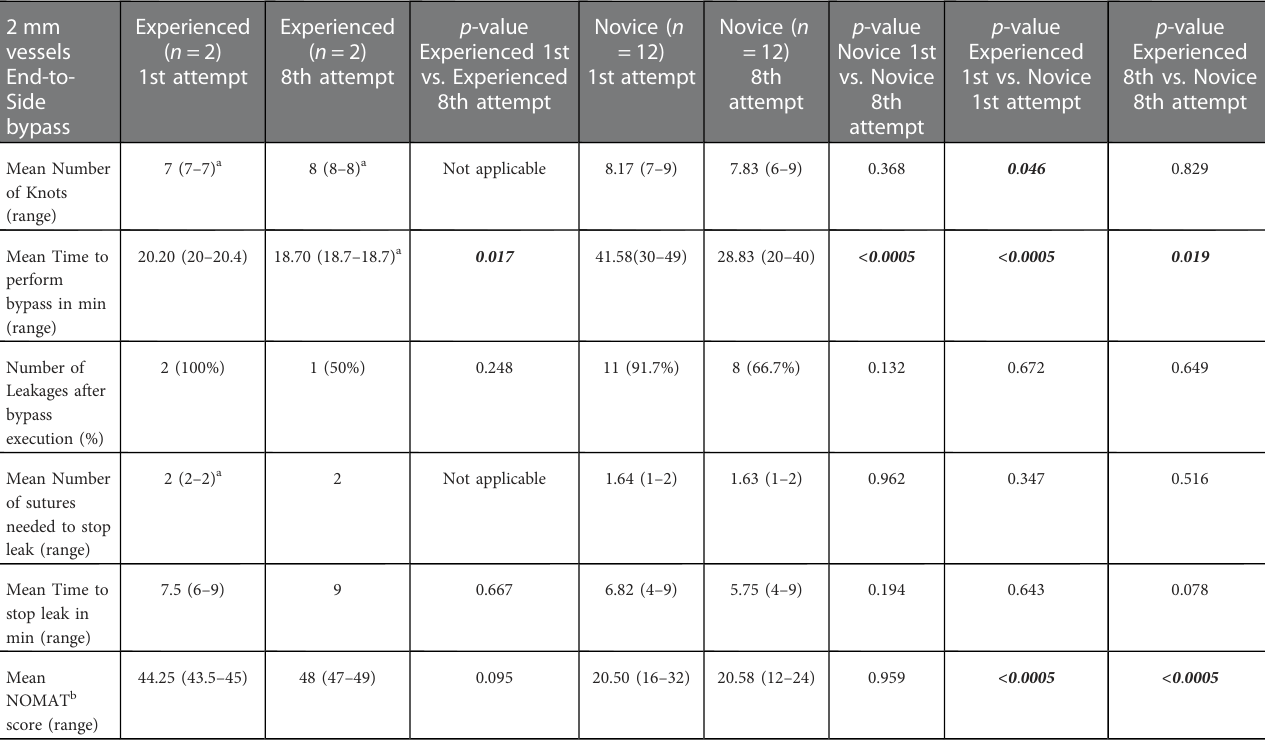
TABLE 2 Results of the NOMAT score and objective task evaluation of the 2 mm vessels end-to-Side bypass in each group at 1st and 8th